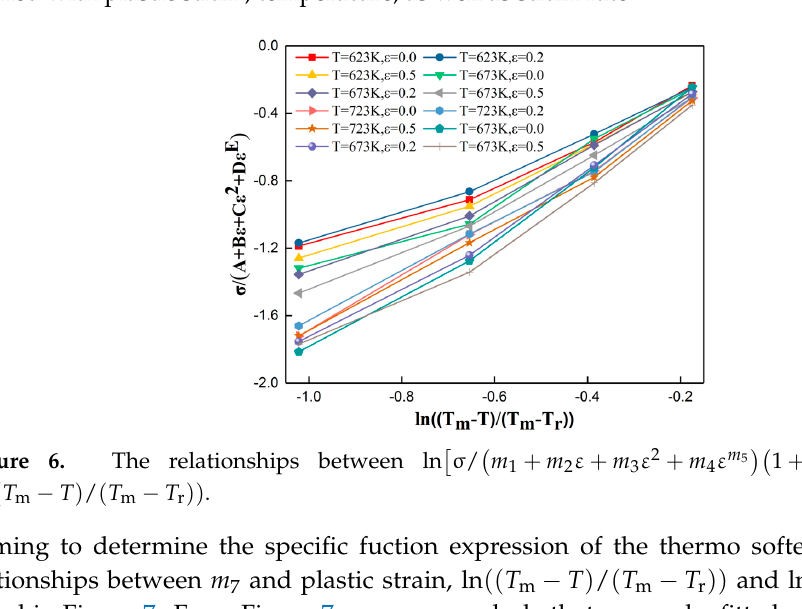
(cid:2) σ (cid:0) m 1 + m 2 ε + m 3 ε 2 + m 4 ε m 5 /